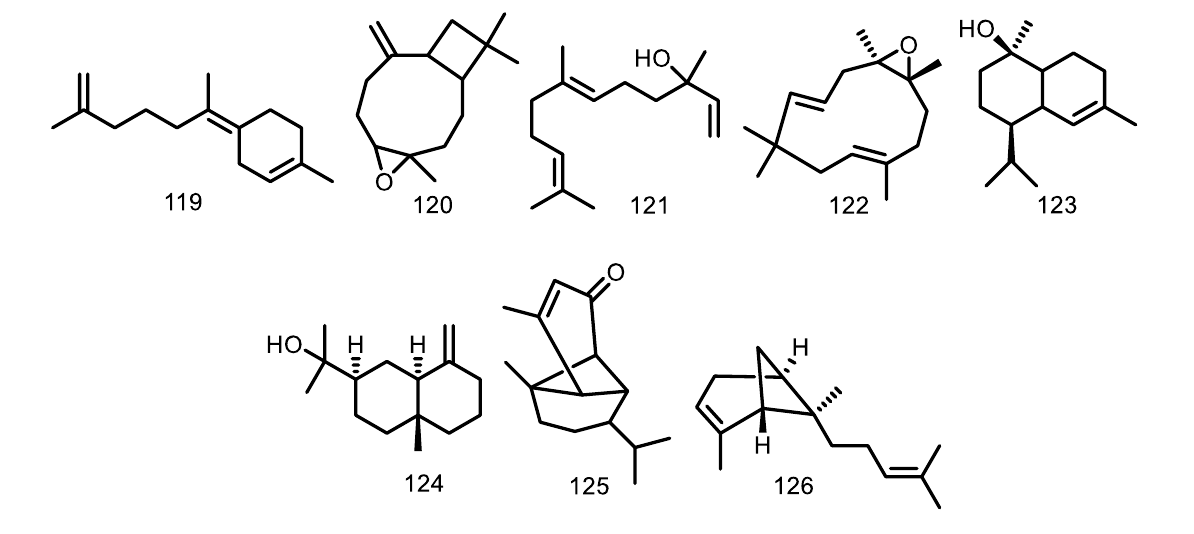
Figure 3. Sesquiterpenoid from Guarea species.